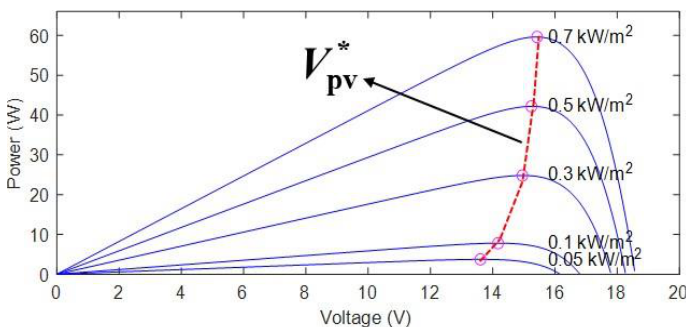
Figure 5. Control strategy of the conventional P&O algorithm.